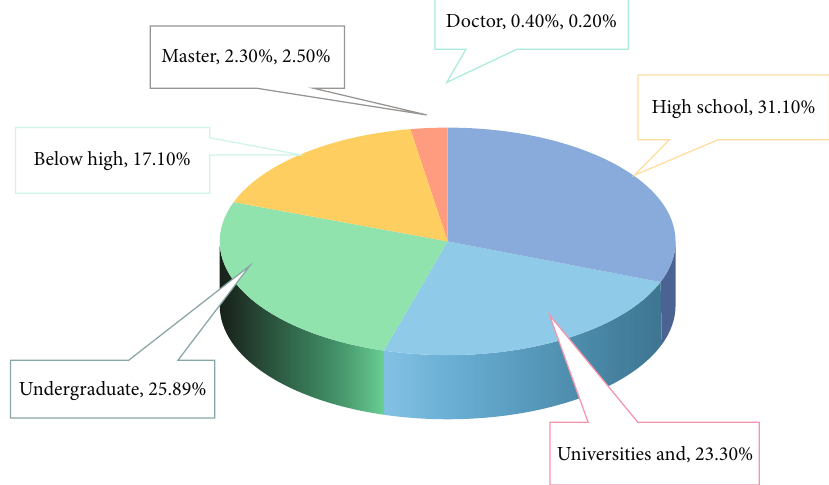
Figure 7: Distribution of education level of Internet users.